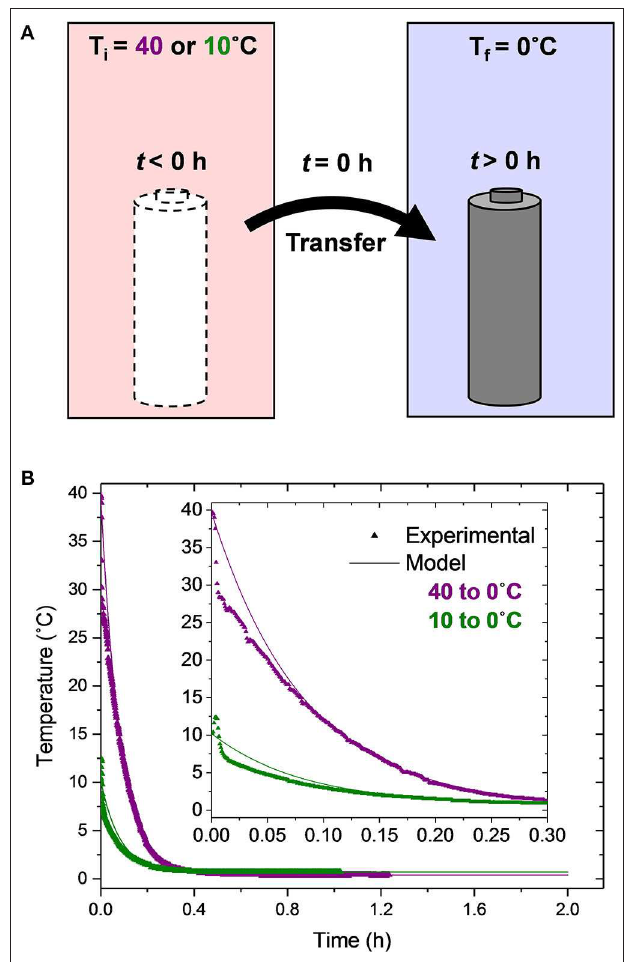
FIGURE 1 | (A) Schematic diagram of the cell transfer process used to create a thermal transient condition and (B) experimentally measured and theoretically predicted cell temperature upon transfer to the 0 ◦ C